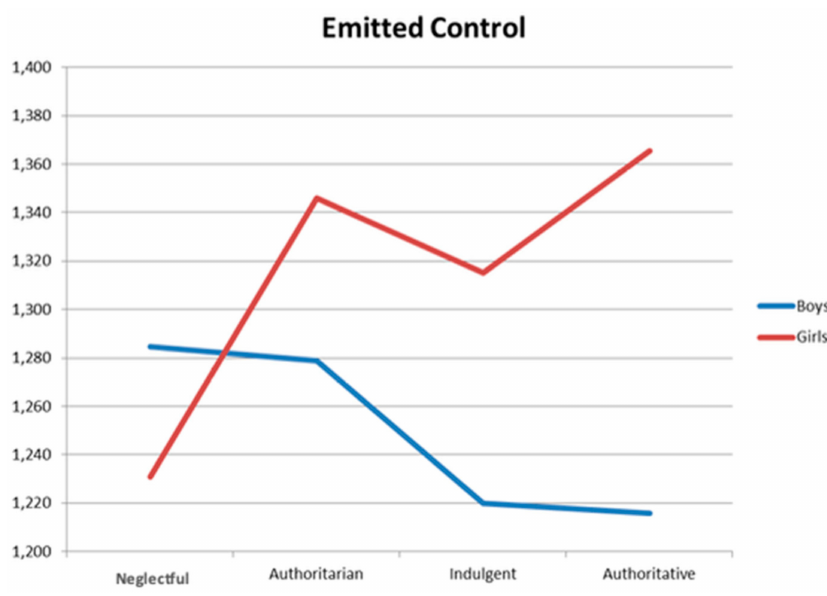
Figure 2. Iteration e ff ect on e-emitted control of the mother´s style.